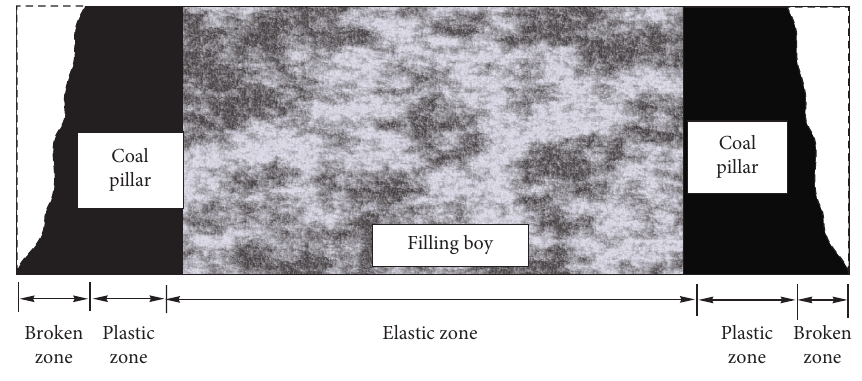
Figure 4: Diagram of Type II CSP.